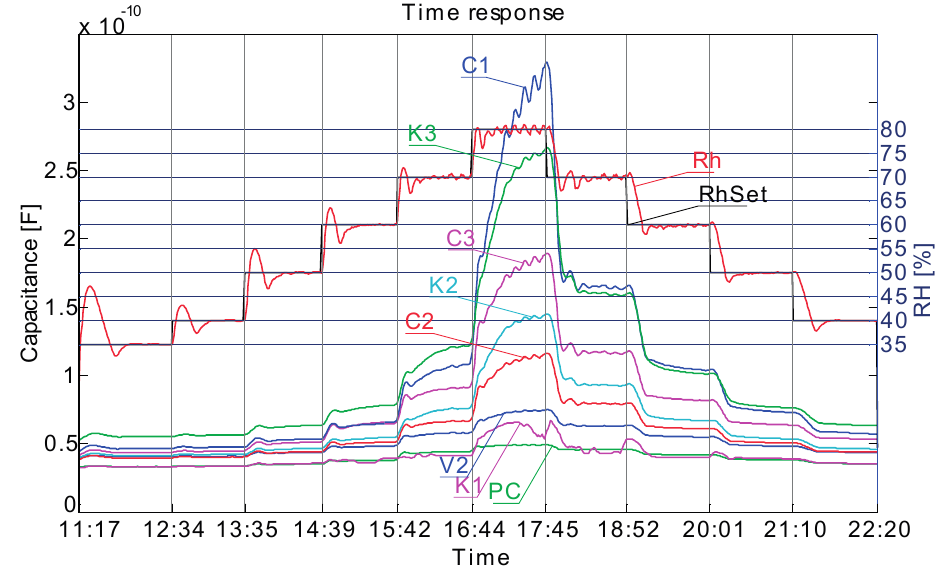
Figure 4 . Time response of comb sensors on different material (C1–C3 recycled paper, K1–K3 cardboard, PC—poly-carbonate 2 × 2 cm, V2—food packaging paper, RhSet—humidity chamber set value, Rh—humidity chamber measured value);